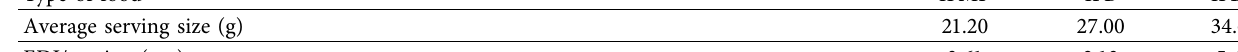
Table 5: Average estimated daily intake of iron per serving of IFMPs, IFBs, and IFBCs and their contribution to RDA. Type of food